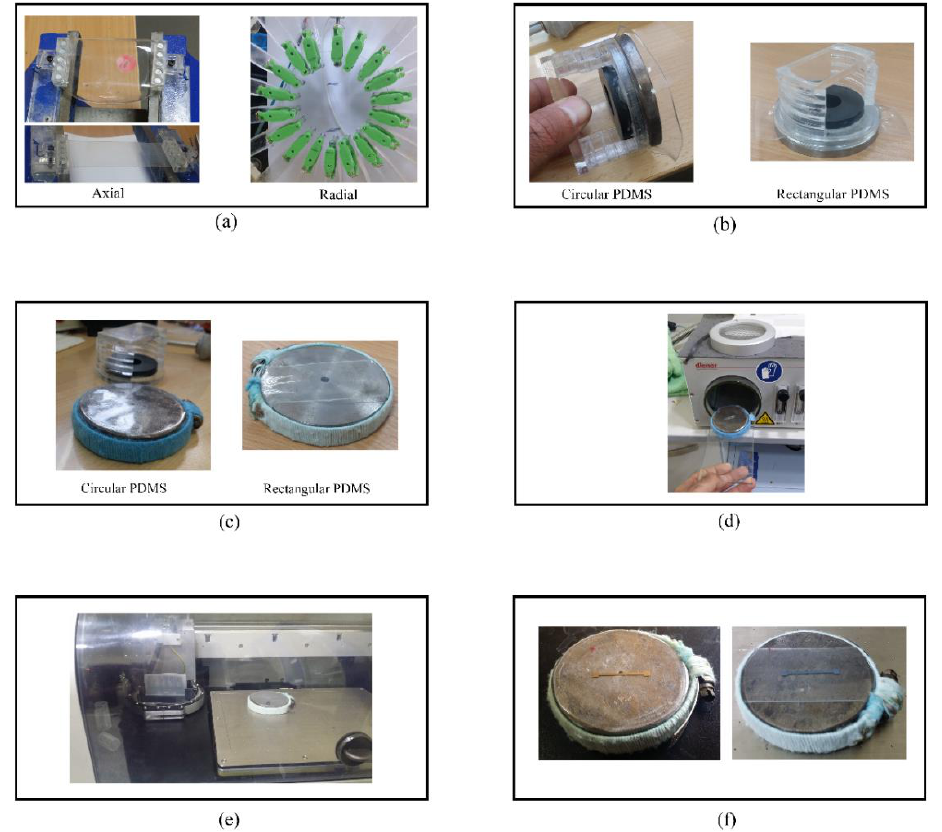
Figure 4. The fabrication process of the stretchable circuits. ( a ) Axial and radial pre-stretching of PDMS; ( b ) placing the stretched PDMS sample between a metal plate and magnetic piece to maintain the pre-stretching strain; ( c ) securing the PDMS sample on the plate using the circular clamp; ( d ) surface treatment of the PDMS sample; ( e ) printing conductive lines using the inkjet printer; and ( f ) sintering the ink in the oven.